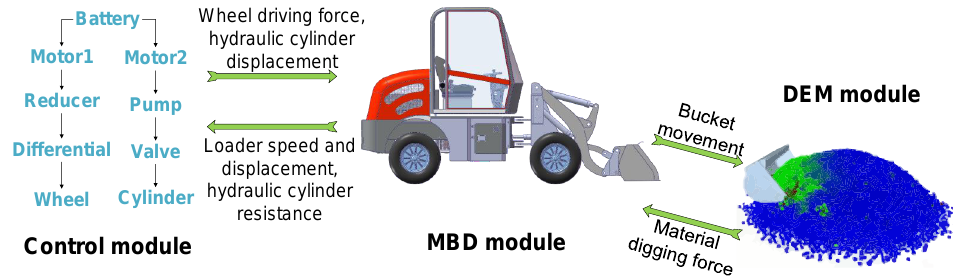
Figure 5. Joint simulation model framework for pure electric